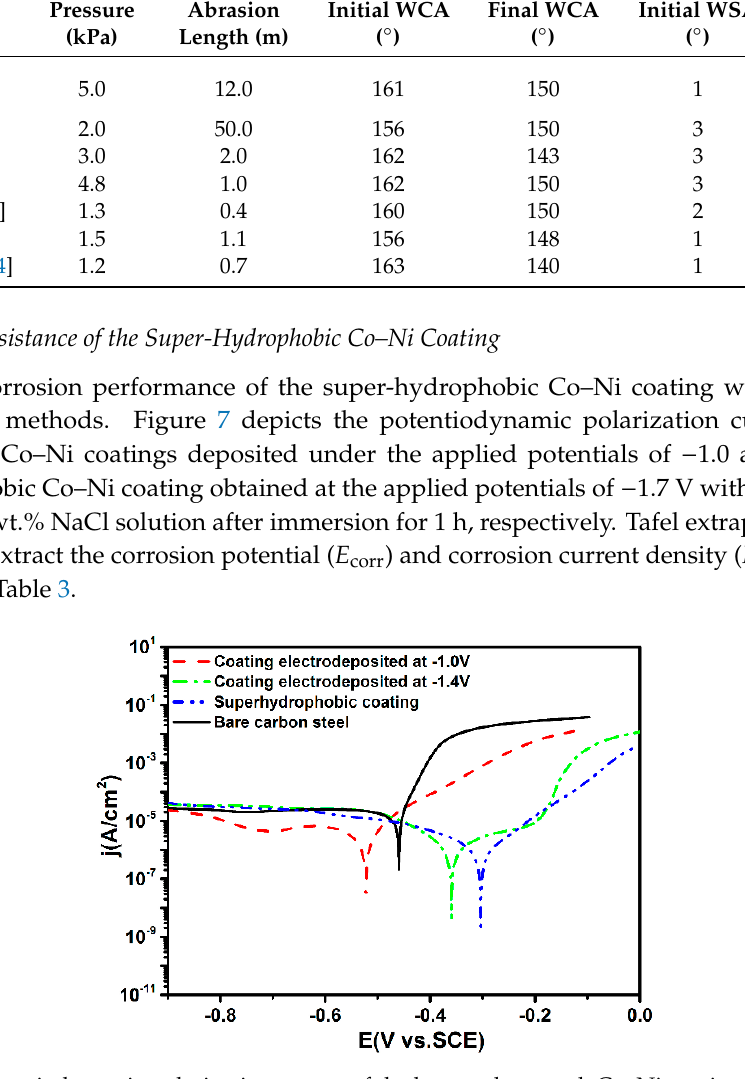
Figure 7. Potentiodynamic polarization curves of the bare carbon steel, Co–Ni coating deposited at − 1.0 and − 1.4 V, and super-hydrophobic Co–Ni coating deposited at − 1.7 V after immersion in 3.5 wt.% NaCl aqueous solution for 1h with a scan rate of 0.5 mV/s. Table 3. Extracted corrosion potential ( E corr ) and current density ( I corr ) from the potentiodynamic polarization measurements presented in Figure 6.